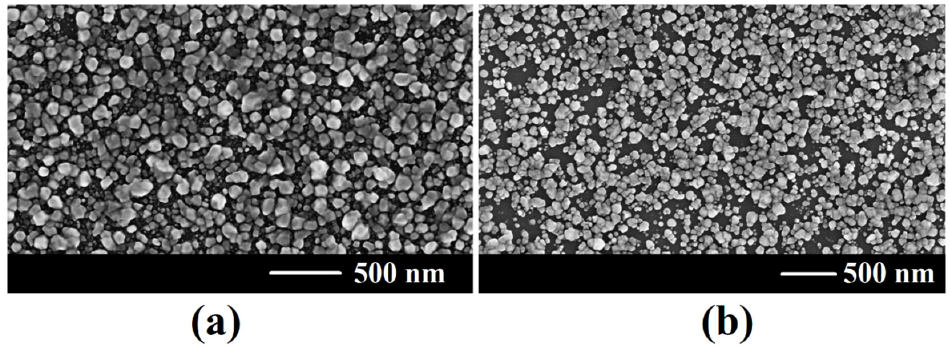
Figure 3. SEM images of electrochemically deposited Fe nanoparticles on bulk (001) GaAs ( a ) and (111)B ( b ) surface for 20